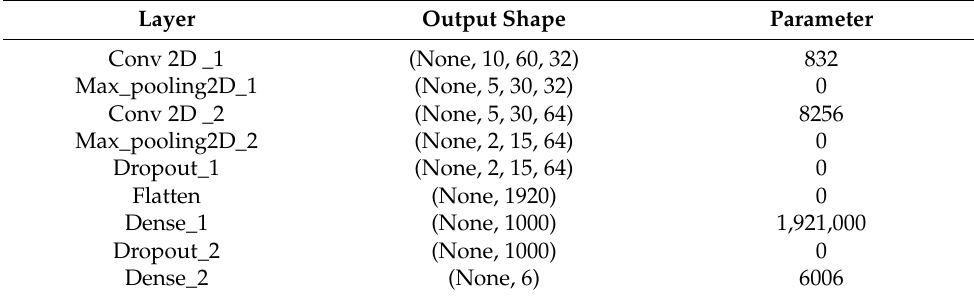
Table 5. Layers and number of parameters in the IMU input